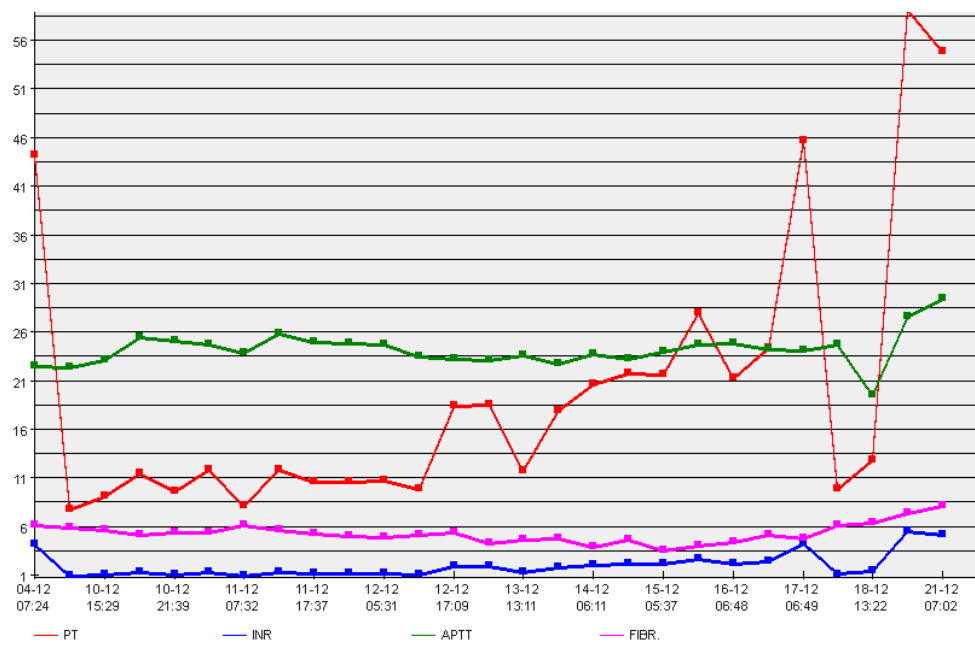
Figure 1. Coagulogram. Prothrombin time—PT, international normalized ratio—INR, activated partial thromboplastin time—APTT, fibrinogen—Fibr. Table 1. Dosage of recombinant activated factor VII, tranexamic acid, and nadroparin after delivery on days